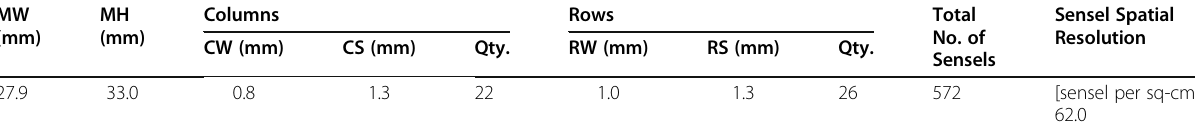
Table 2 Tekscan pressure mapping sensor 4000 specifications [23]